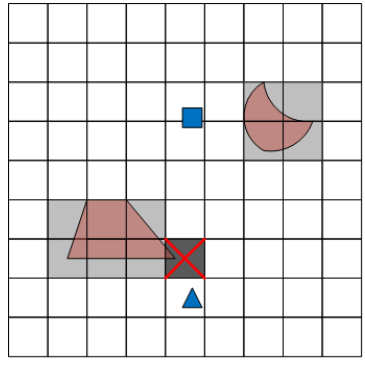
Figure 2. Discretized map with the original orientation.